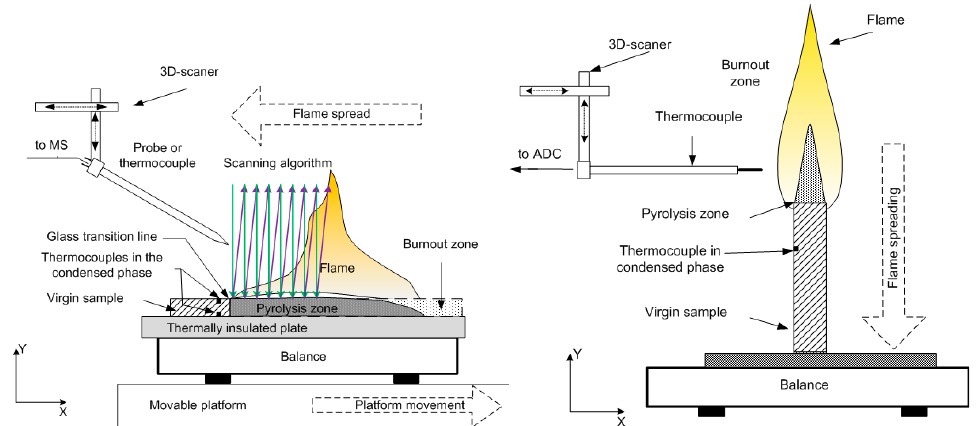
Figure 1. An experimental setup for the study of horizontal ( left ) and vertical ( right ) flame spread over the polymer surface and for measuring temperature and species concentration profiles.